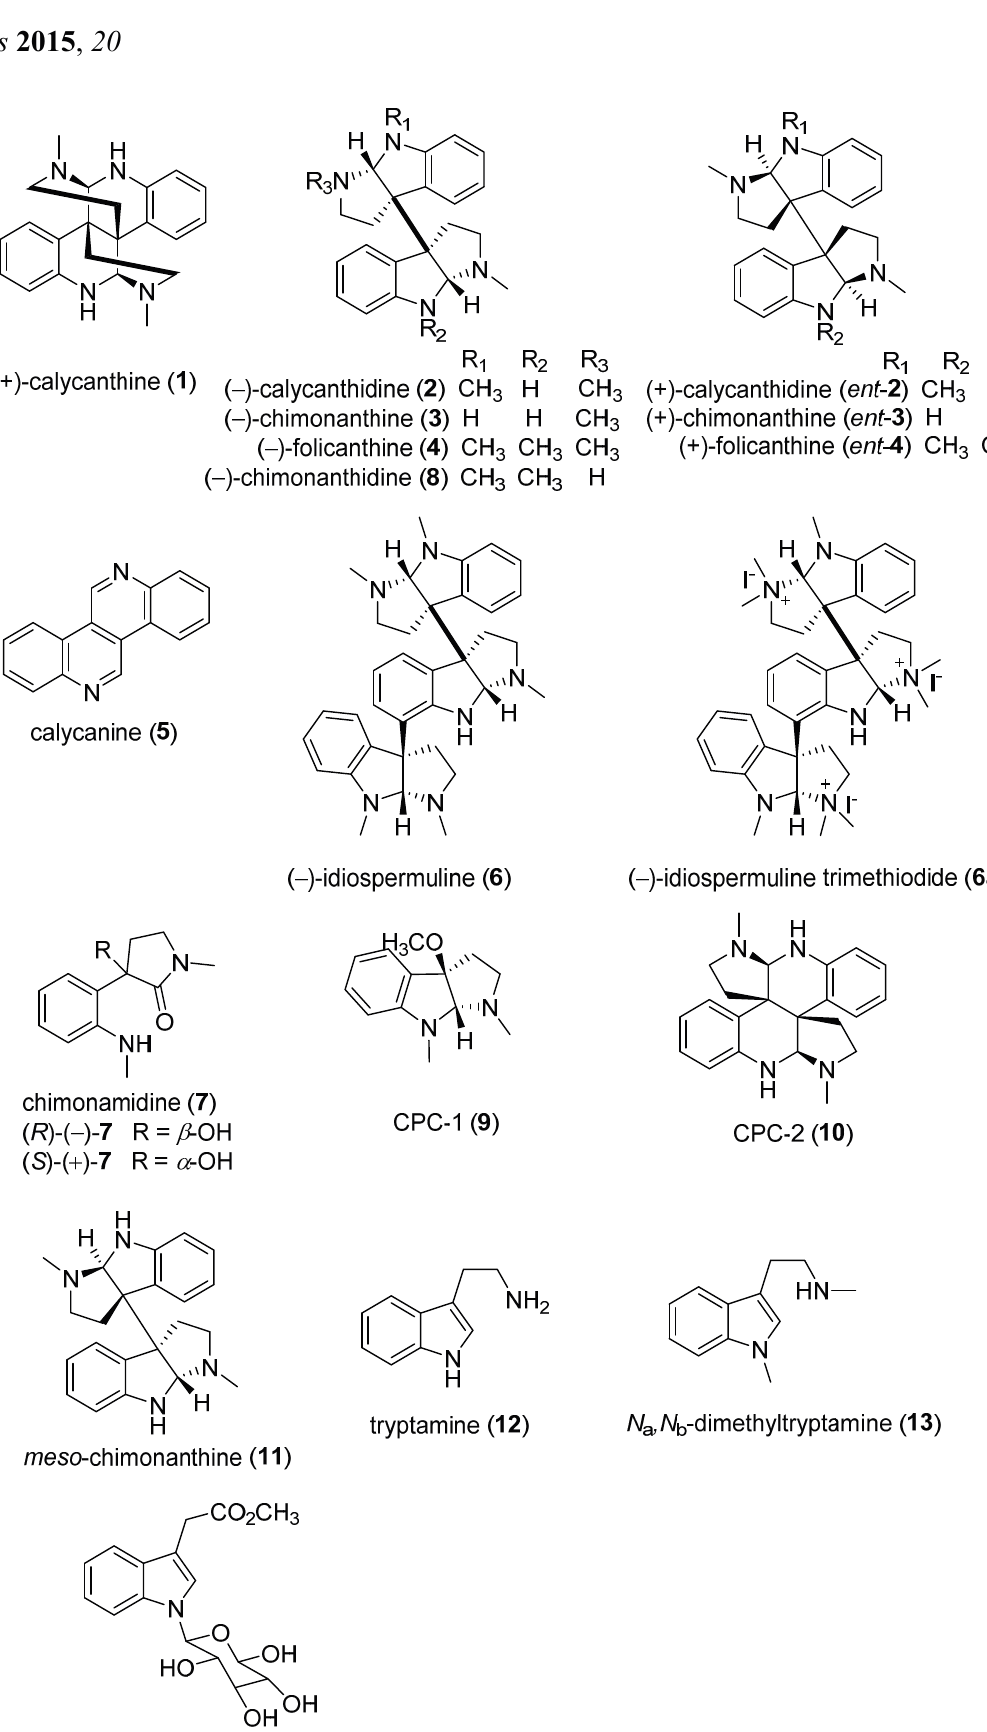
Figure 1. Structures of the Calycanthaceae